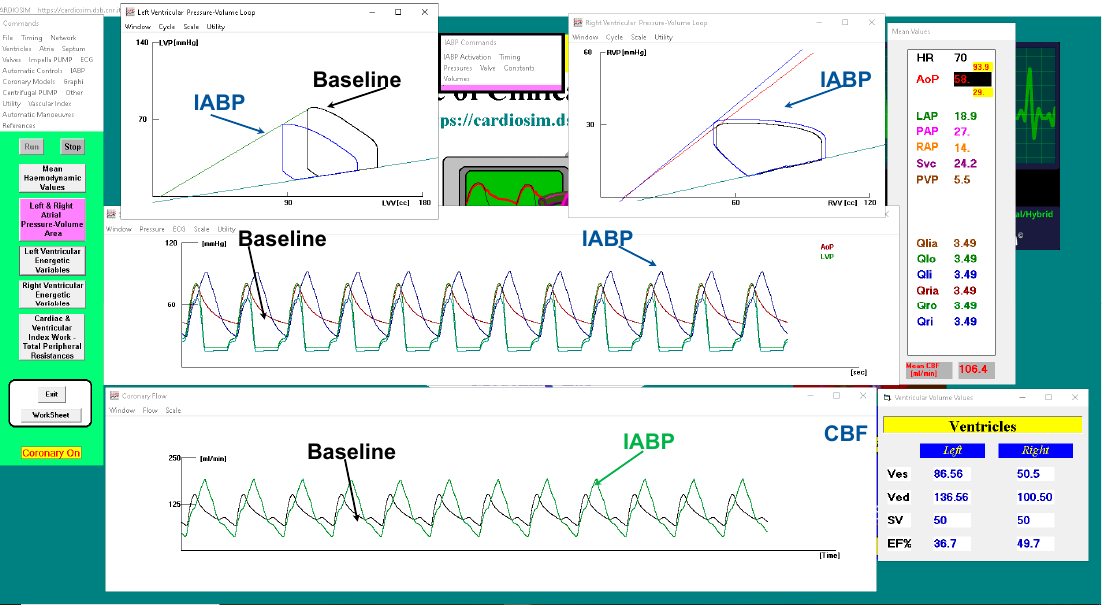
Figure 10. CARDIOSIM © screenshot showing baseline and assisted conditions with IABP. Proceeding from the top left to the right and then down, the left (top left side) and right (top right side) ventricular pressure–volume loops for baseline and IABP support are observed. The left ventricular and aortic pressure waveforms for baseline (red line) and IABP assistance (blue line) are plotted in the middle window. The bottom window shows the coronary blood flow